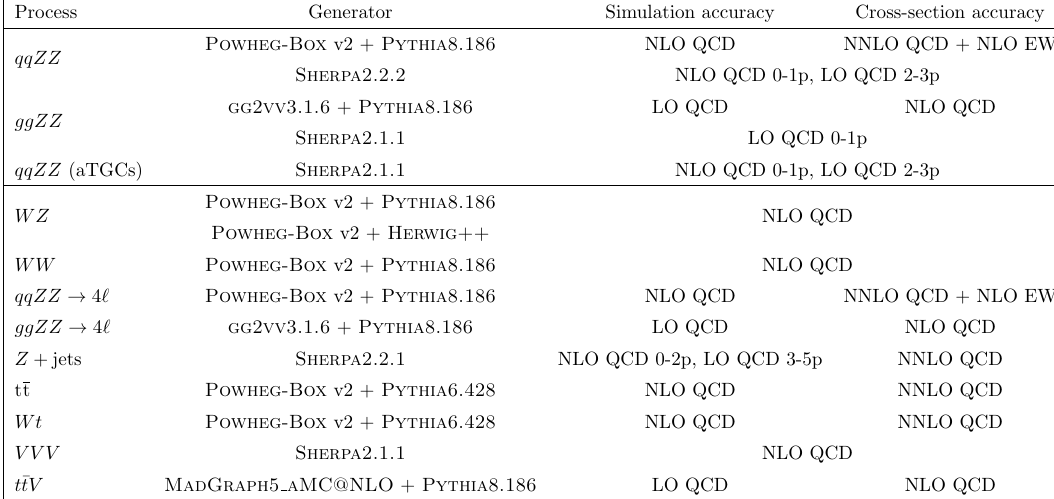
Table 1 . Summary of Monte Carlo event simulation tools with their theoretical accuracy for each process, where \p" stands for parton(s). For the (cid:12)rst two signal processes and the WZ process, the (cid:12)rst (second) row describes the baseline (alternative) simulation. The theoretical accuracy of the normalisation used for the total production cross-section of each process is shown in the last